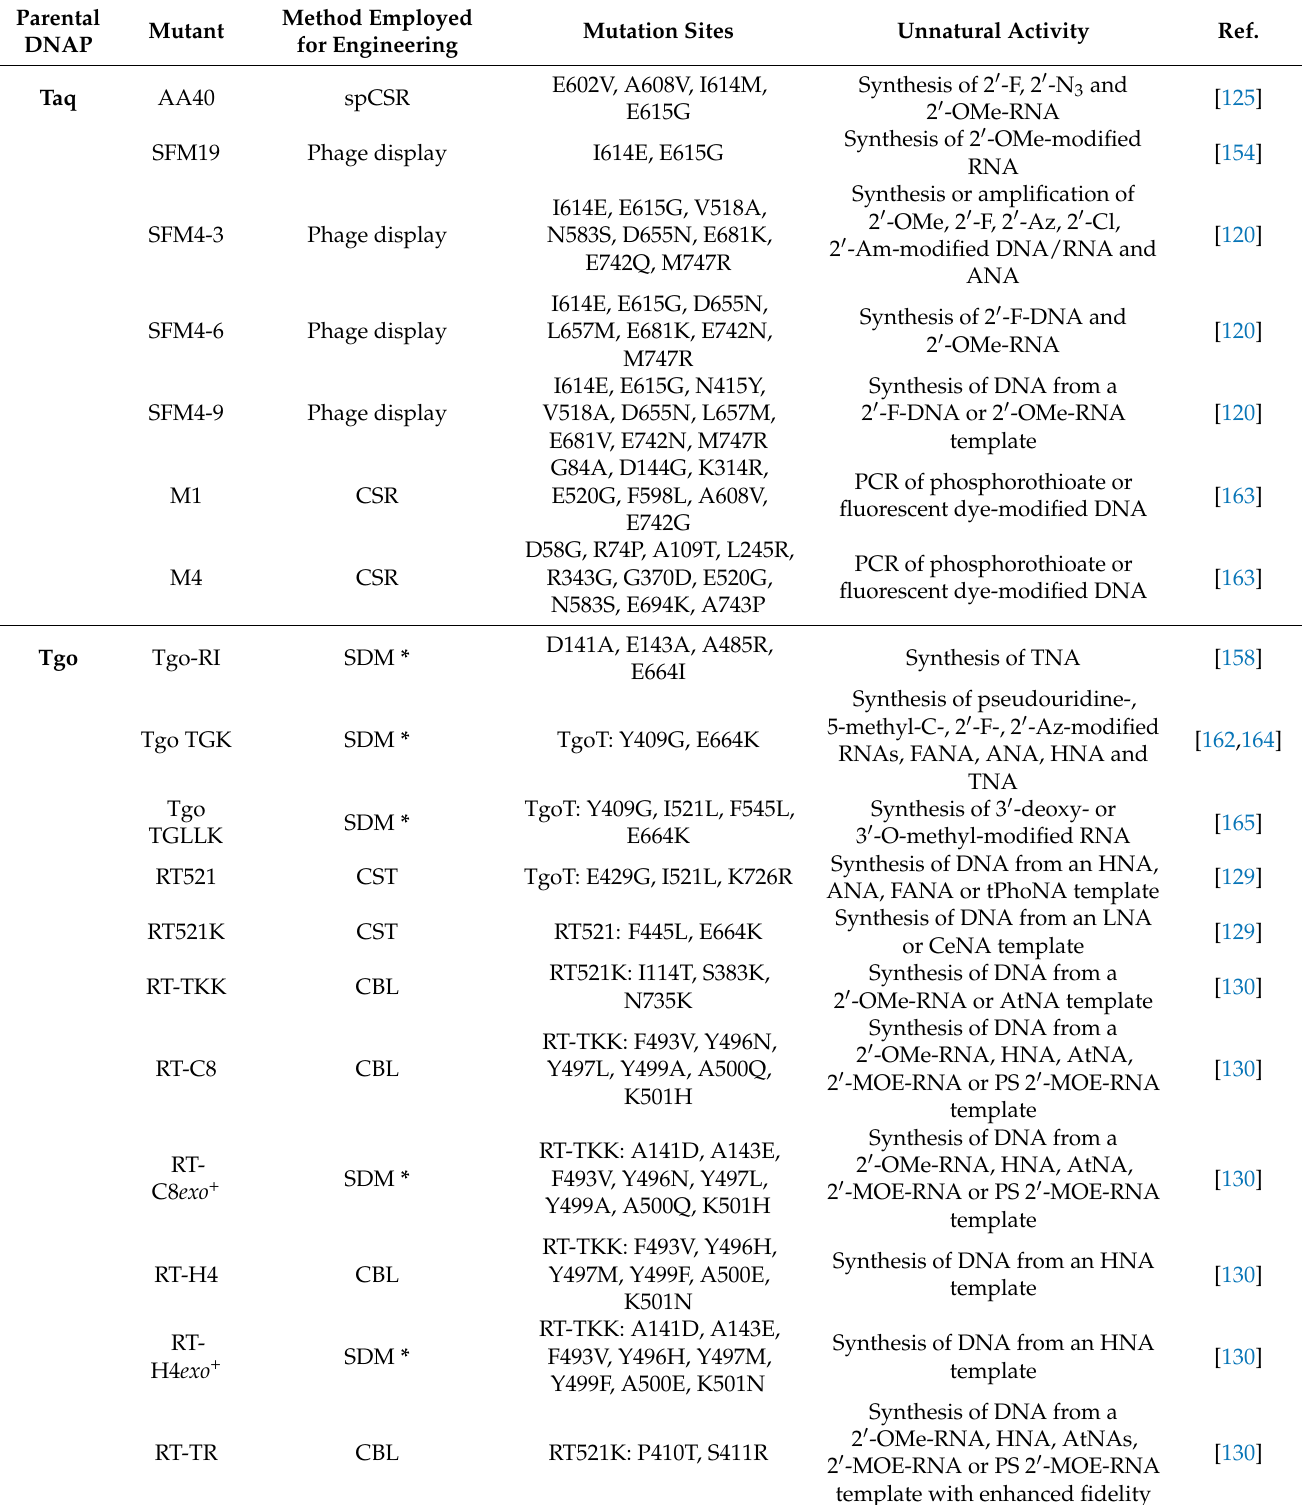
Table 2. Summary of engineered thermophilic and hyperthermophilic